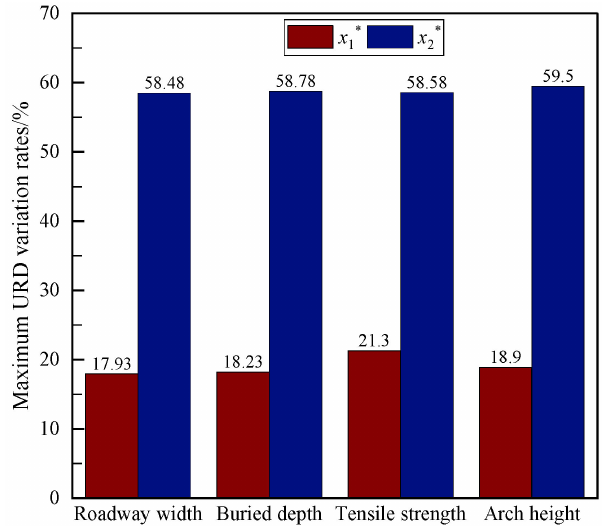
Figure 8. Maximum URD variation rates under different influencing